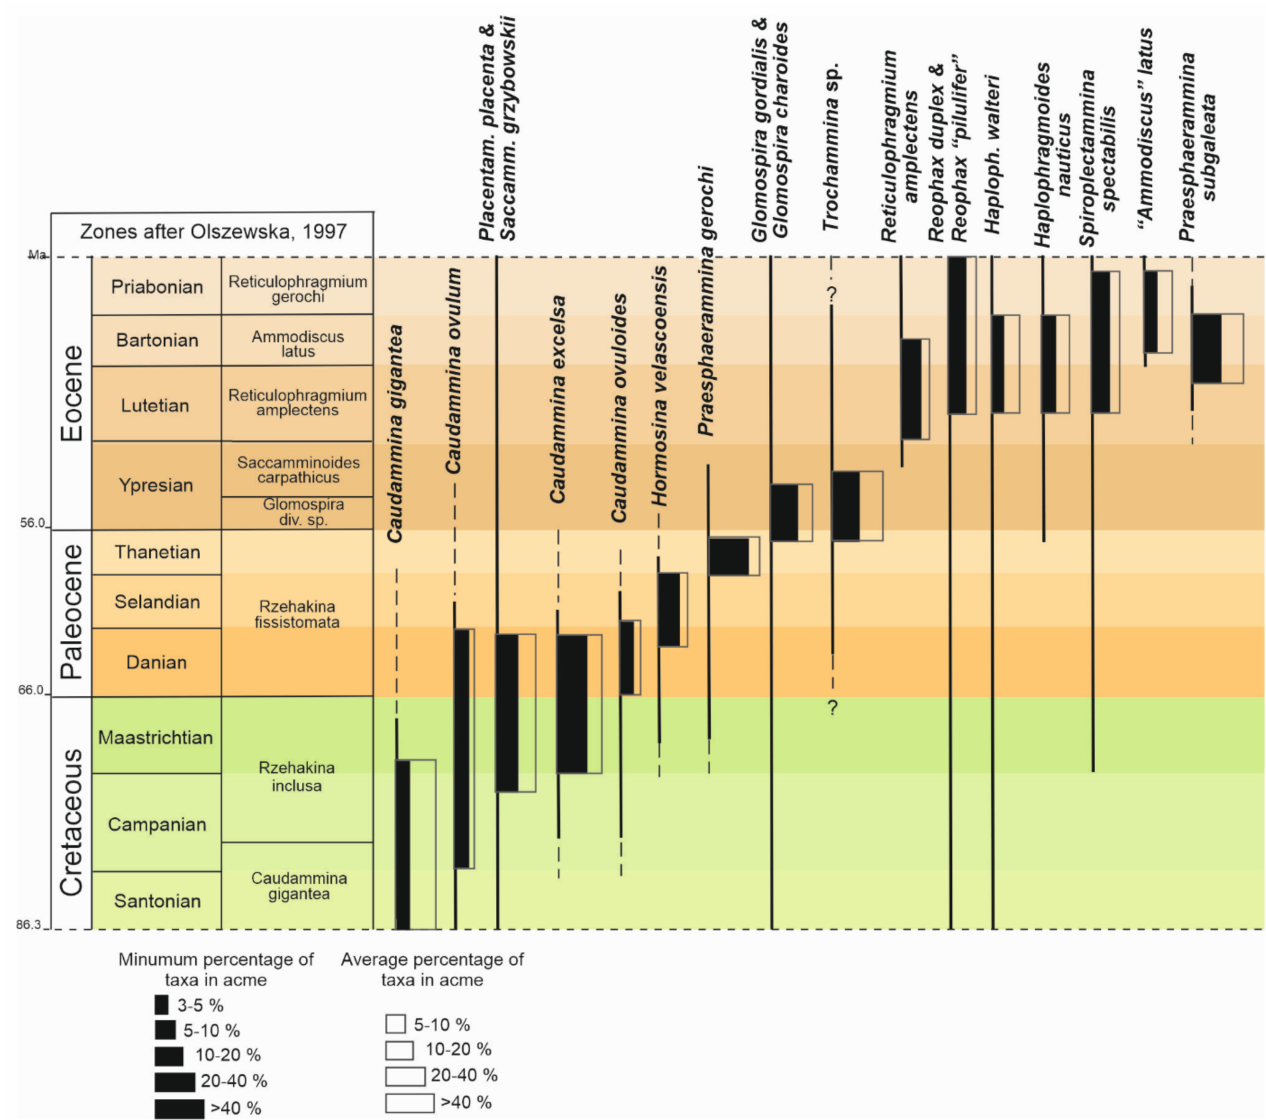
Figure 3. Biostratigraphical scheme of upper Cretaceous and lower Paleogene with distribution of taxa acmes in the Outer Carpathians (time scale after